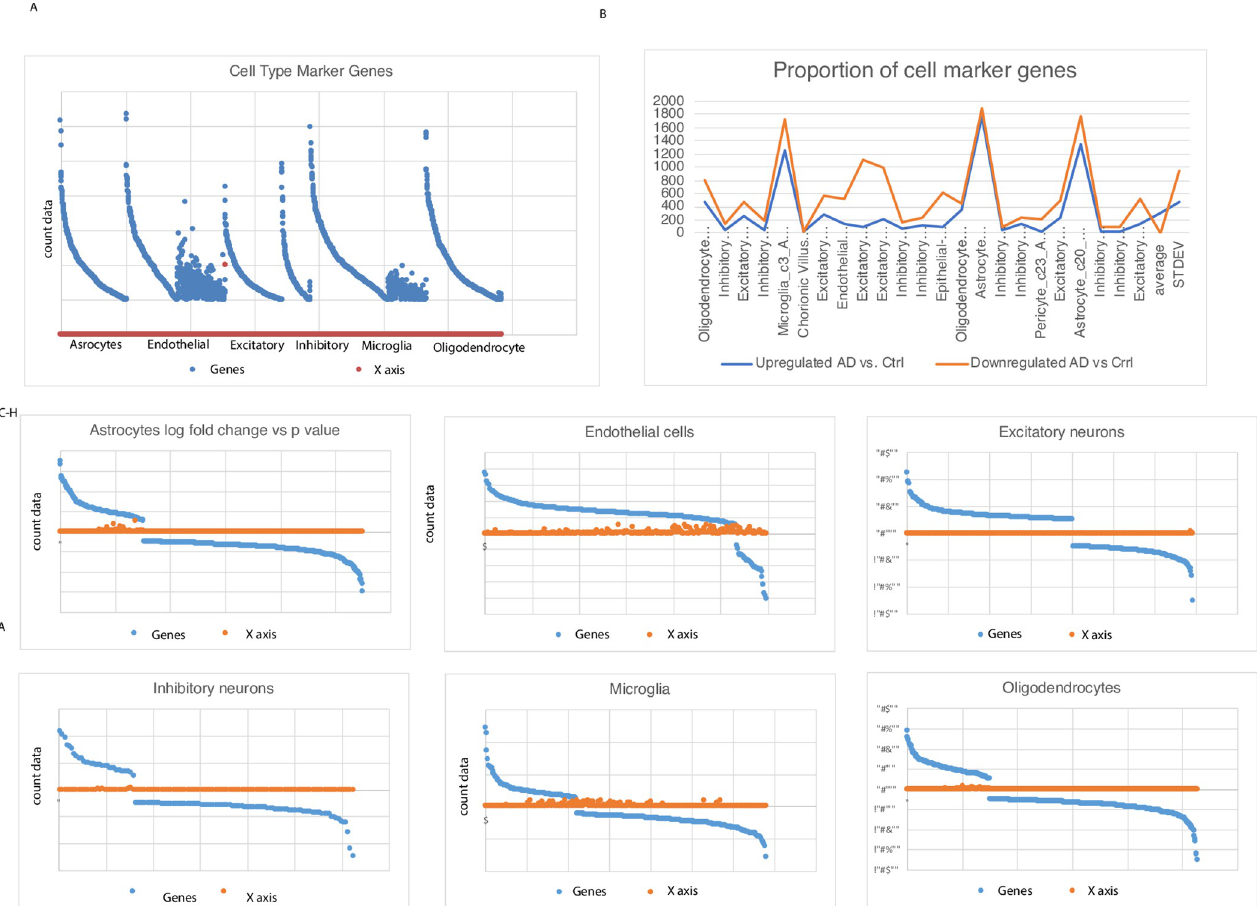
Fig 6. Cell type specific marker genes. Left panel: Plot of cell type marker genes detected as altered in AD compared to control samples based on the single cell Alzheimer’s seq data analysis (of 7 neuronal cell type gene markers). Top right panel: Proportion (percent) of astrocytes and oligonucleotide cell specific marker genes. X axis: Cell types, y axis: Seq count data. The expression data is plotted in blue. Right: Another plot of the promotion of cell marker genes (blue/; upregulated in AD vs control, red: Down) Y axis range: 0–2000 X axis: Different cell-type marker gene groups (e.g oligodendrocytes, inhibitory excitatory neurons microglia astrocytes). Bottom left: Count data gene plots (fold change vs p value). Astrocyte cell marker genes fold change vs p value, right panel: Endothelial cell marker genes. Right panel: Excitatory neurons. Lower panel: Inhibitory neurons, microglia and oligodendrocyte marker genes. Blue: Alzheimer’s brain samples, orange: Control. Y axis: Gene count values of cell type marker genes, x axis: 6 cell type marker gene categories (left—astrocytes, endothelial cell markers, excitatory neurons, inhibitory neurons microglia and oligodendrocytes).), astrocyte and A) A gene network of macroglia and oligodendrocytes. The genes are plotted in blue and red and gene symbols are given. The genes are marked in blue or red according to the sample type (control/ Alzheimer’s). Down panel plots: 7 cell types count data.